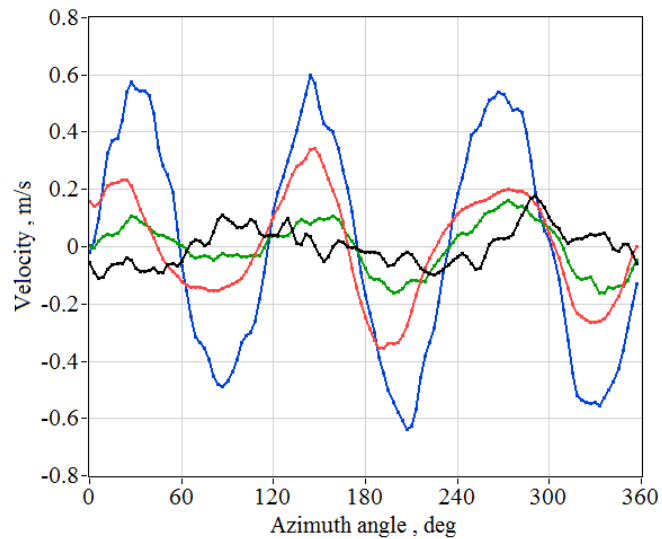
Figure 5. Dependence of (cid:101) V L ( h k / sin ϕ , θ m ) on the azimuth angle θ m as obtained from measurements by the StreamLine lidar from 00:00 to 00:30 on 23 July 2016 at the heights h k = 150 m (black curve), 300 m (red curve), 450 m (green curve), and 600 m (blue